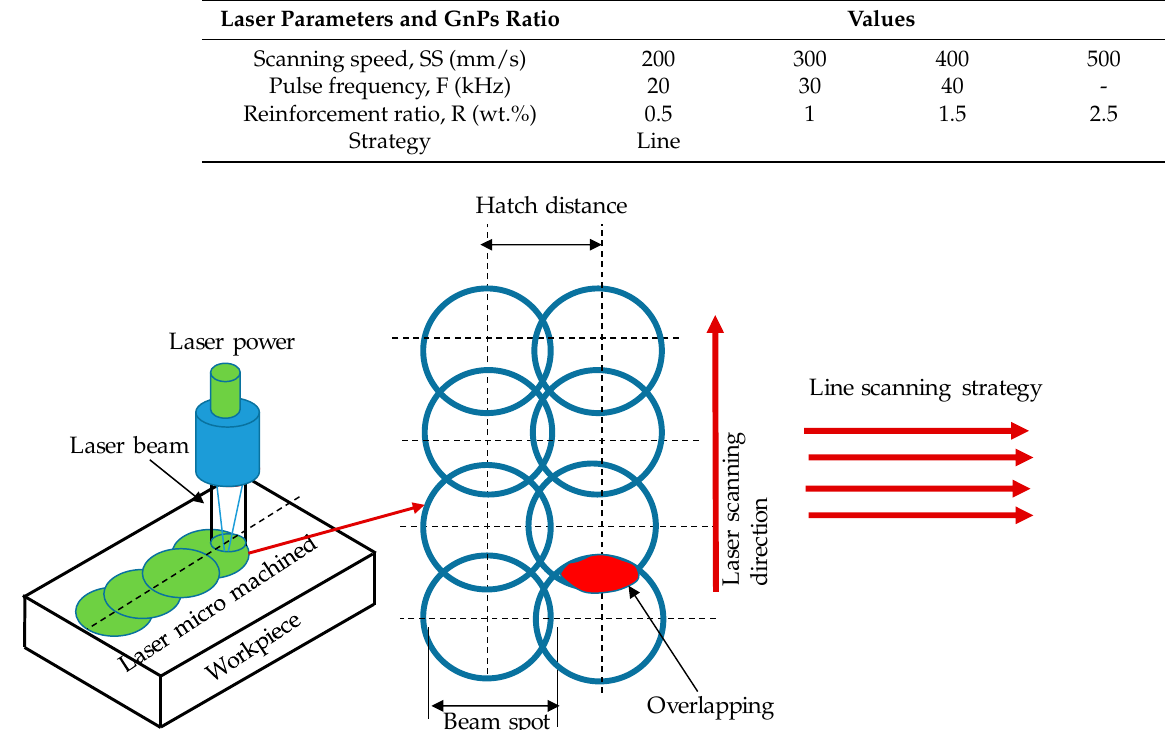
Figure 3. Graphical representation of the laser ablation track and line scanning strategy .